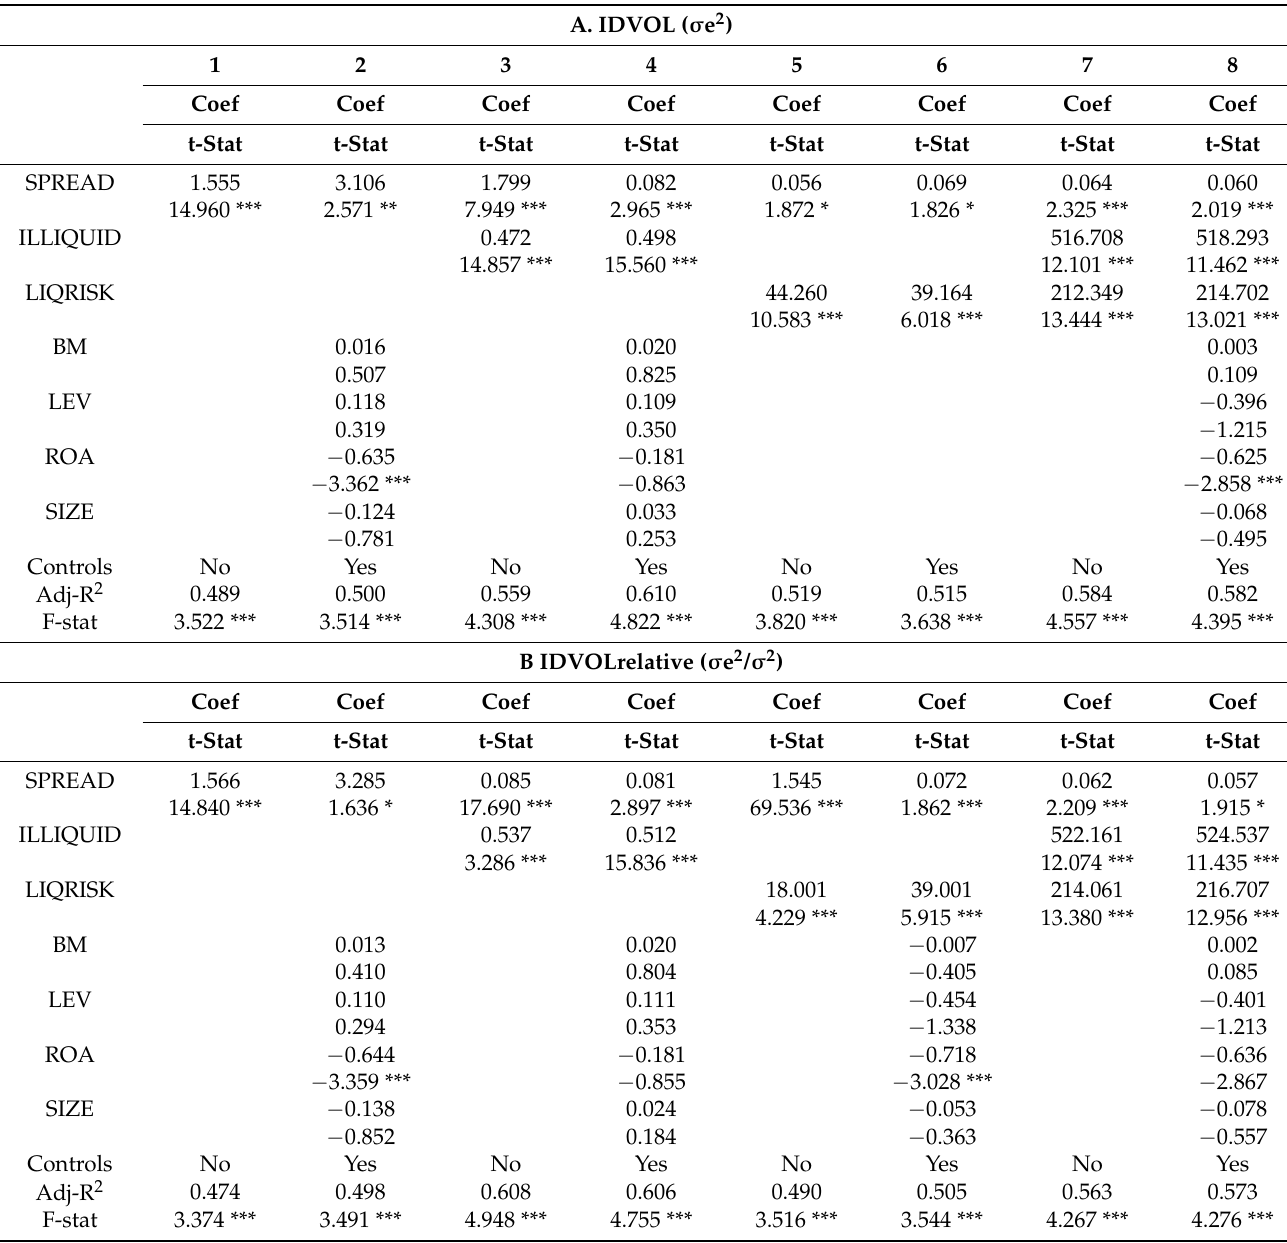
Table 8. Information environment, information asymmetry, and idiosyncratic